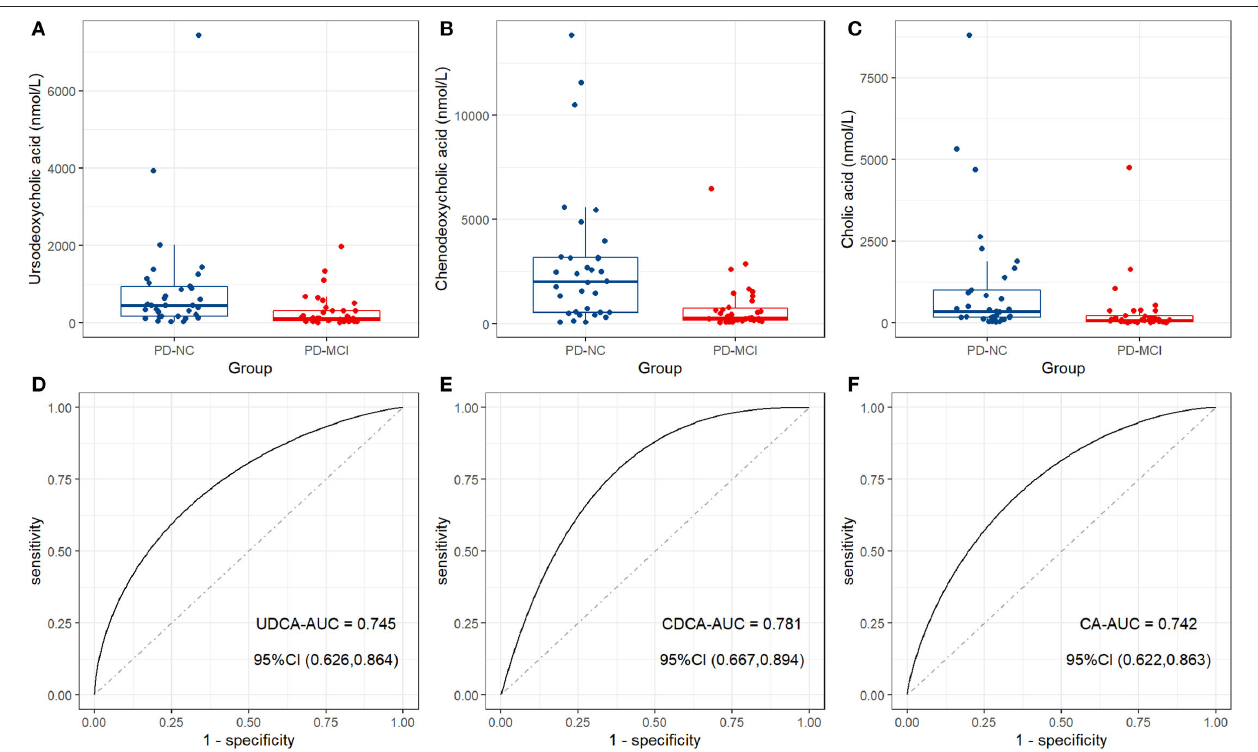
FIGURE 2 | The distinct bile acid profile in patients with PD-MCI compared to patients with PD-NC. Box plots show the median (the horizontal line), 25–75 percentile (the box), and 5–95 percentile (the whisker) of the three BAs with VIP > 1 and FDR-corrected p -value < 0.05: (A) Ursodeoxycholic acid (UDCA); (B) chenodeoxycholic acid (CDCA); (C) cholic acid (CA). ROC curve analysis shows the diagnostic efficacy of CA (D) , CDCA (E) , and UDCA (F) for distinguishing between patients with PD-MCI and patients with